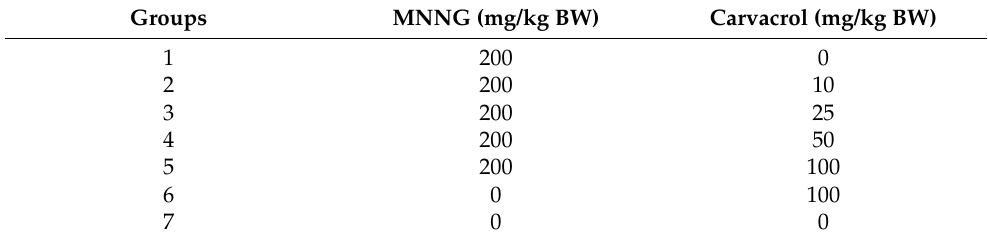
Table 1. The study design presents seven groups of Wistar rats ( n = 7) exposed to MNNG or MNNG and different doses of carvacrol, only high doses of carvacrol, and none of MNNG and carvacrol, respectively.